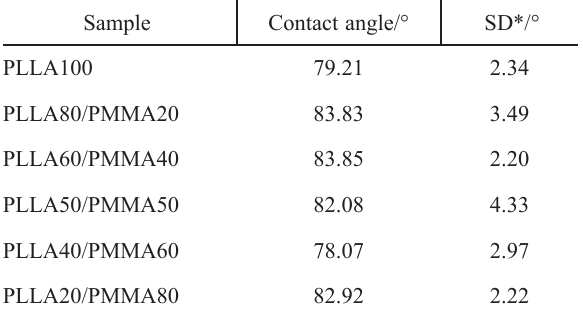
Table 2 – Values of contact angle of water droplets on the examined surfaces of poly(L-lactic acid) – PLLA, poly(methyl methacrylate) – PMMA, and their blends